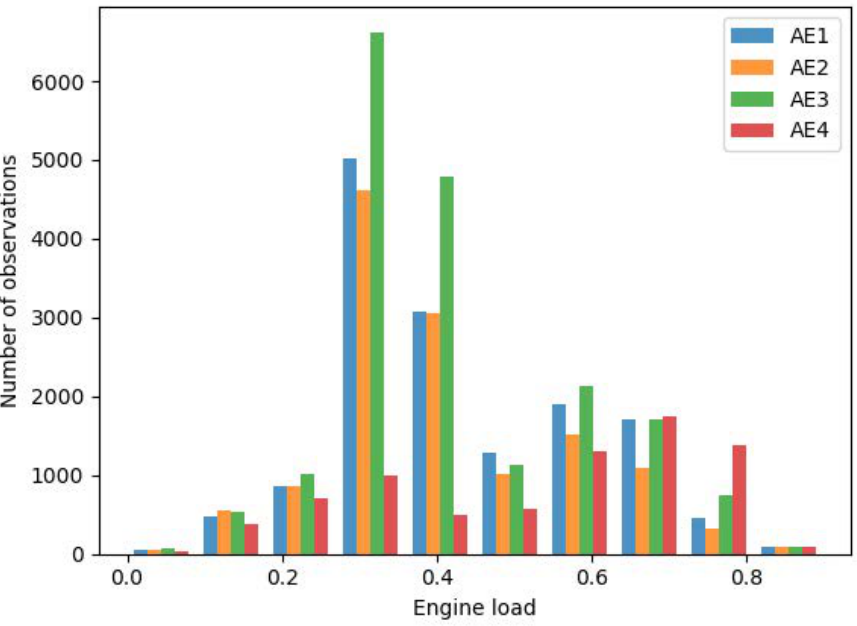
Figure 10. Yearly load distribution of the ship’s auxiliary